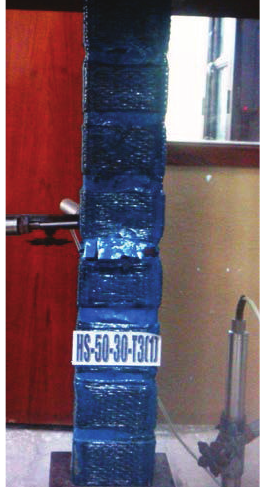
Figure 10: Failure mode of column HS-50-30-T3 (1) .